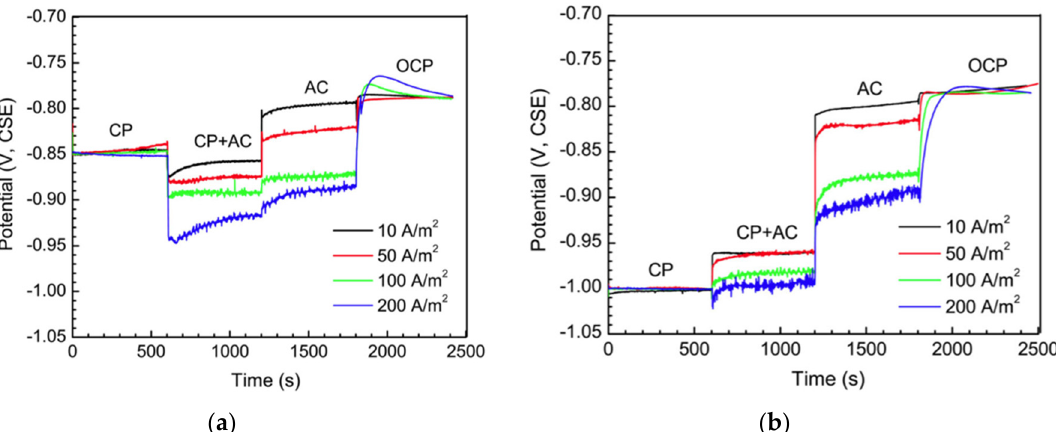
Figure 2. Effect of AC density on DC potential of X65 steel in near-neutral pH bicarbonate solution in cathodic protection condition: ( a ) − 0.85 V vs. CSE, ( b ) − 1 V vs. CSE [54].